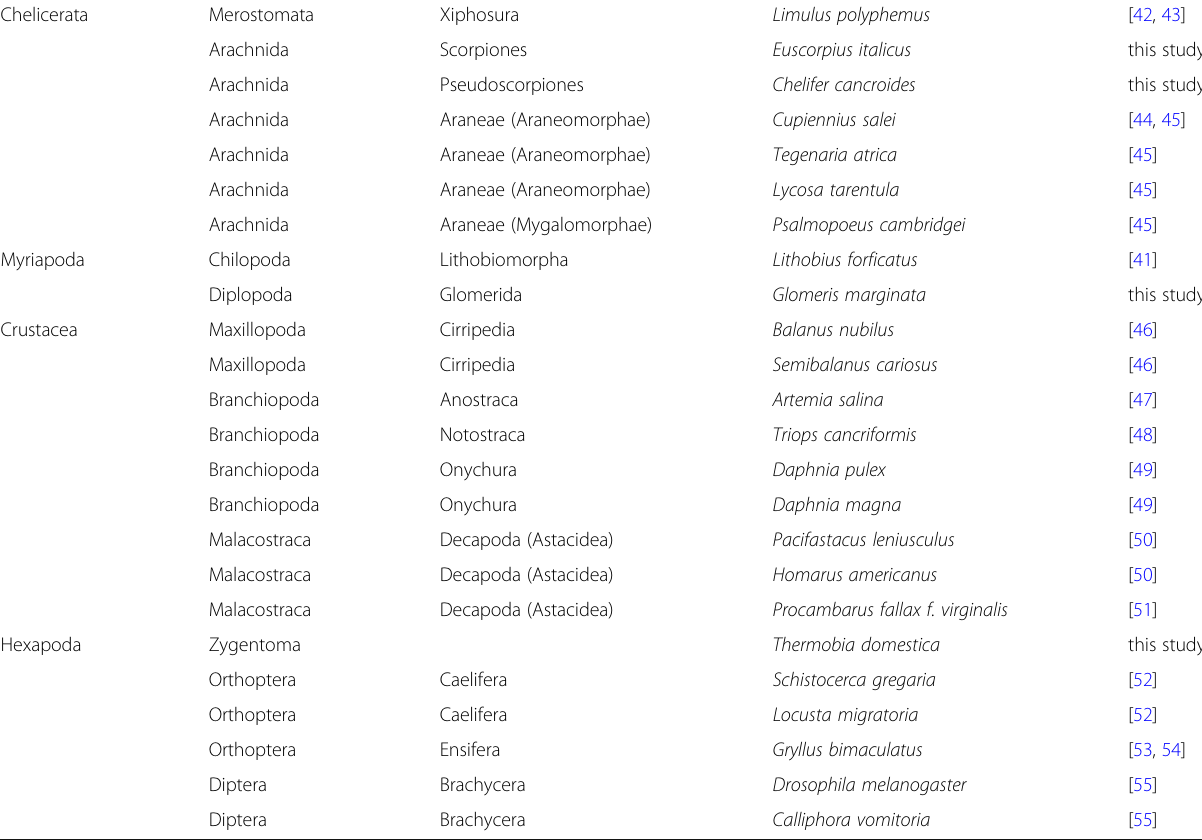
Table 1 Euarthropod species, in which histaminergic neurons have been investigated within the entire ventral cord